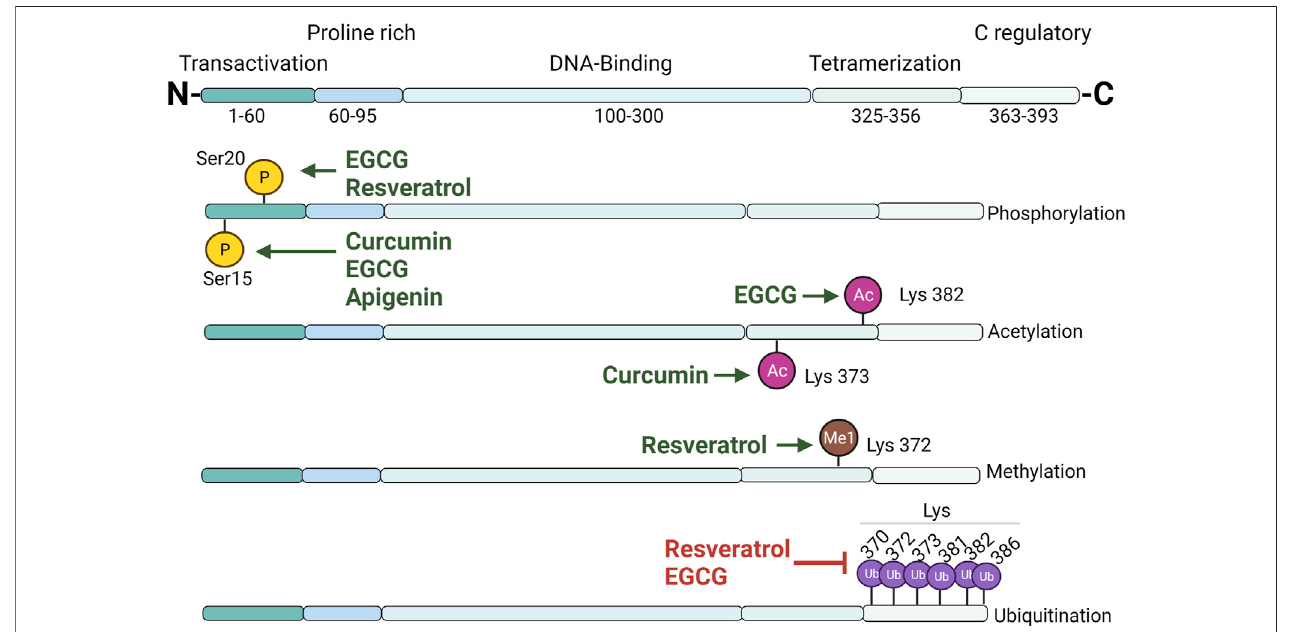
FIGURE 2 | Overview of p53 domain structure and posttranslational modi fi cations induced by polyphenols. Principal sites where polyphenols induce p53 posttranslational modi fi cations (phosphorylation, acetylation, methylation, or ubiquitination) are plotted. TAD, transactivation domain; PRD, proline-rich domain; DBD, DNA-binding domain; TD, tetramerization domain; CRD, C-terminal regulatory